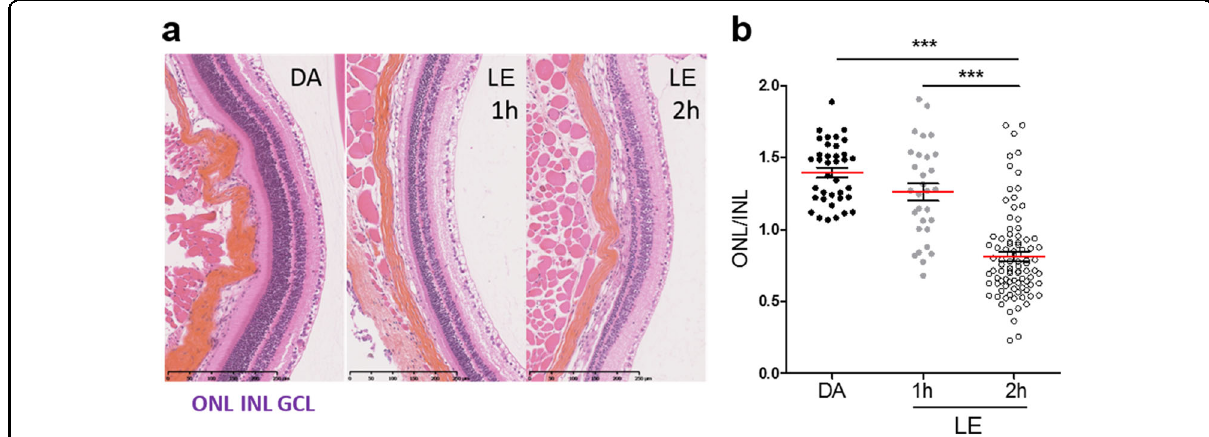
Fig. 1 Susceptibility of retinae from Abca4 − / − mice to acute light-induced degeneration. a Representative hematoxylin/eosin/saffron (HES)- stained retinal sections from Abca4 − / − mice after dark adaptation (DA) or bright light exposure (LE) for 1 or 2 h followed by darkness for 5 days. ONL outer nuclear layer, INL inner nuclear layer, GCL ganglion cell layer. b Quanti fi cation of photoreceptor loss measured as a ratio of outer and inner nuclear layer thickness (ONL/INL) under the conditions stated in a . The INL thickness did not change signi fi cantly with light exposure and was used as the internal reference. Light exposure for 2 h signi fi cantly decreased ONL thickness compared to the DA control condition and 1-h light exposure. The data are presented as a scatterplot, and red bars indicate the mean ± SEM from n ≥ 30 ratios, *** p < 0.001 one-way ANOVA with Bonferroni ’ s posttest.